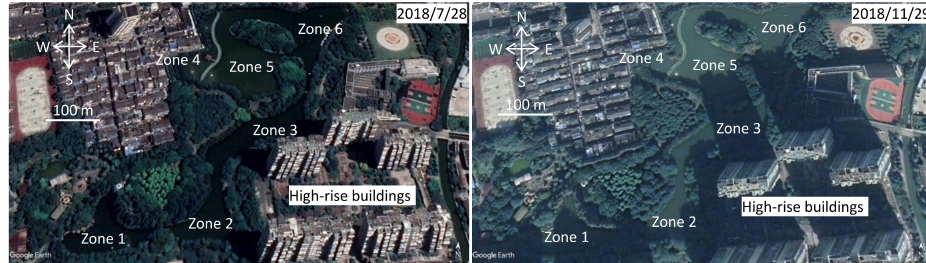
Figure 9. Satellite view of MA pond surrounded by trees and buildings in July and November 2018 (images from Google Earth). Shades of buildings from the sun (around noon) are visible. Zones 1–3 were widely shaded by buildings from the sun in the